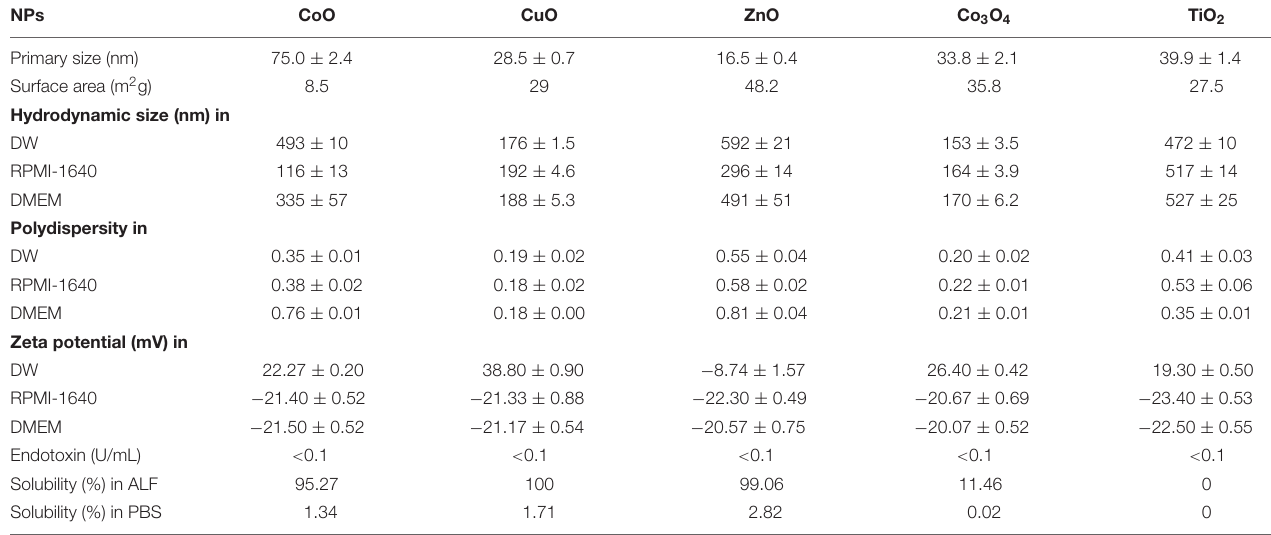
TABLE 1 | Physicochemical properties of NPs.